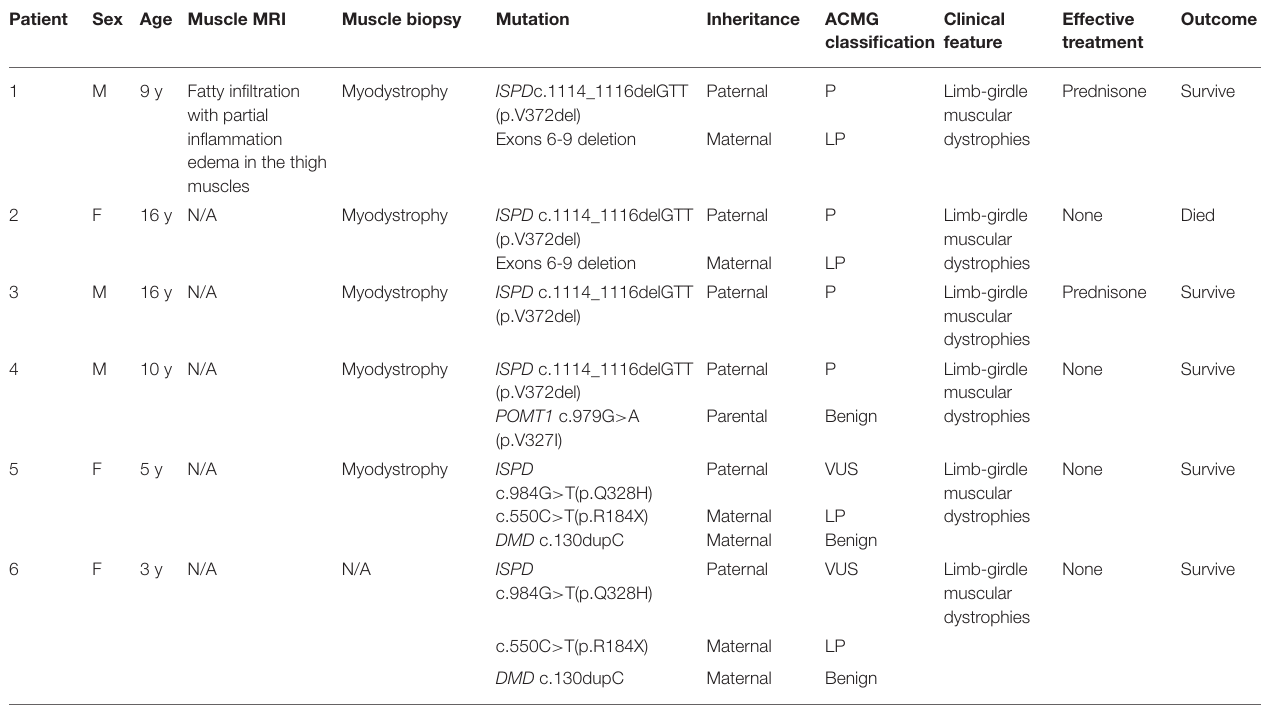
TABLE 1 | Genotype and phenotype analysis of the 6 patients with ISPD mutation. Patient Sex Age Muscle MRI Muscle biopsy ACMG